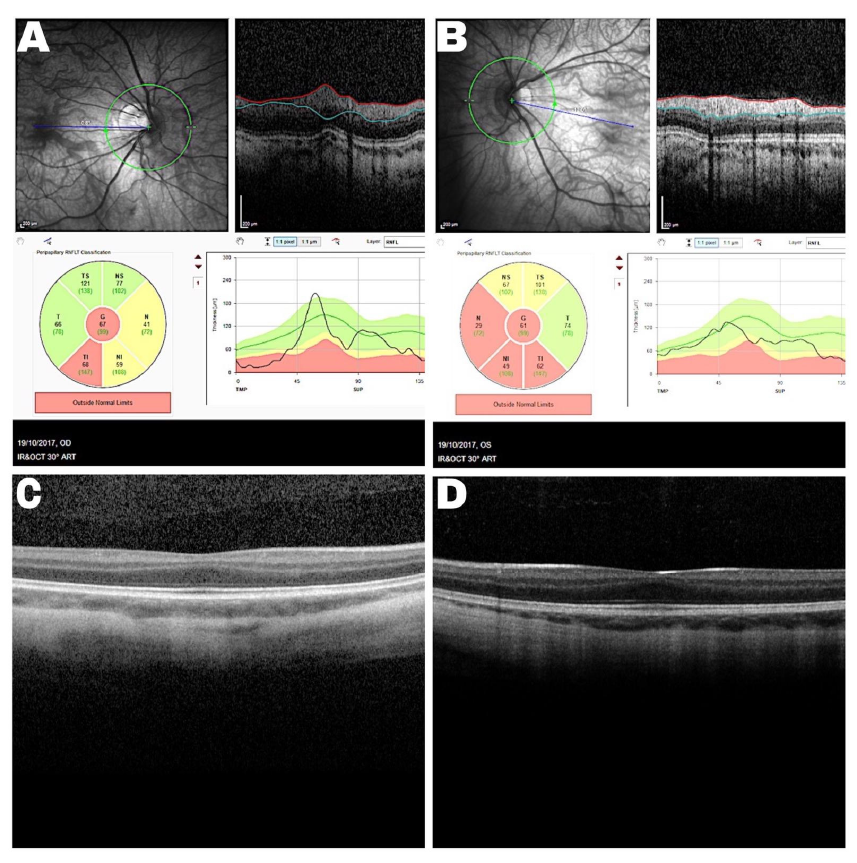
Figure 2. Spectral domain optic coherence tomography (SD-OCT) of the proband showing nerve fiber layer thinning in the right ( A ) and left ( B ) eye. SD-OCT macular scan demonstrates fovea plana in the right ( C ) and left eye ( D ).